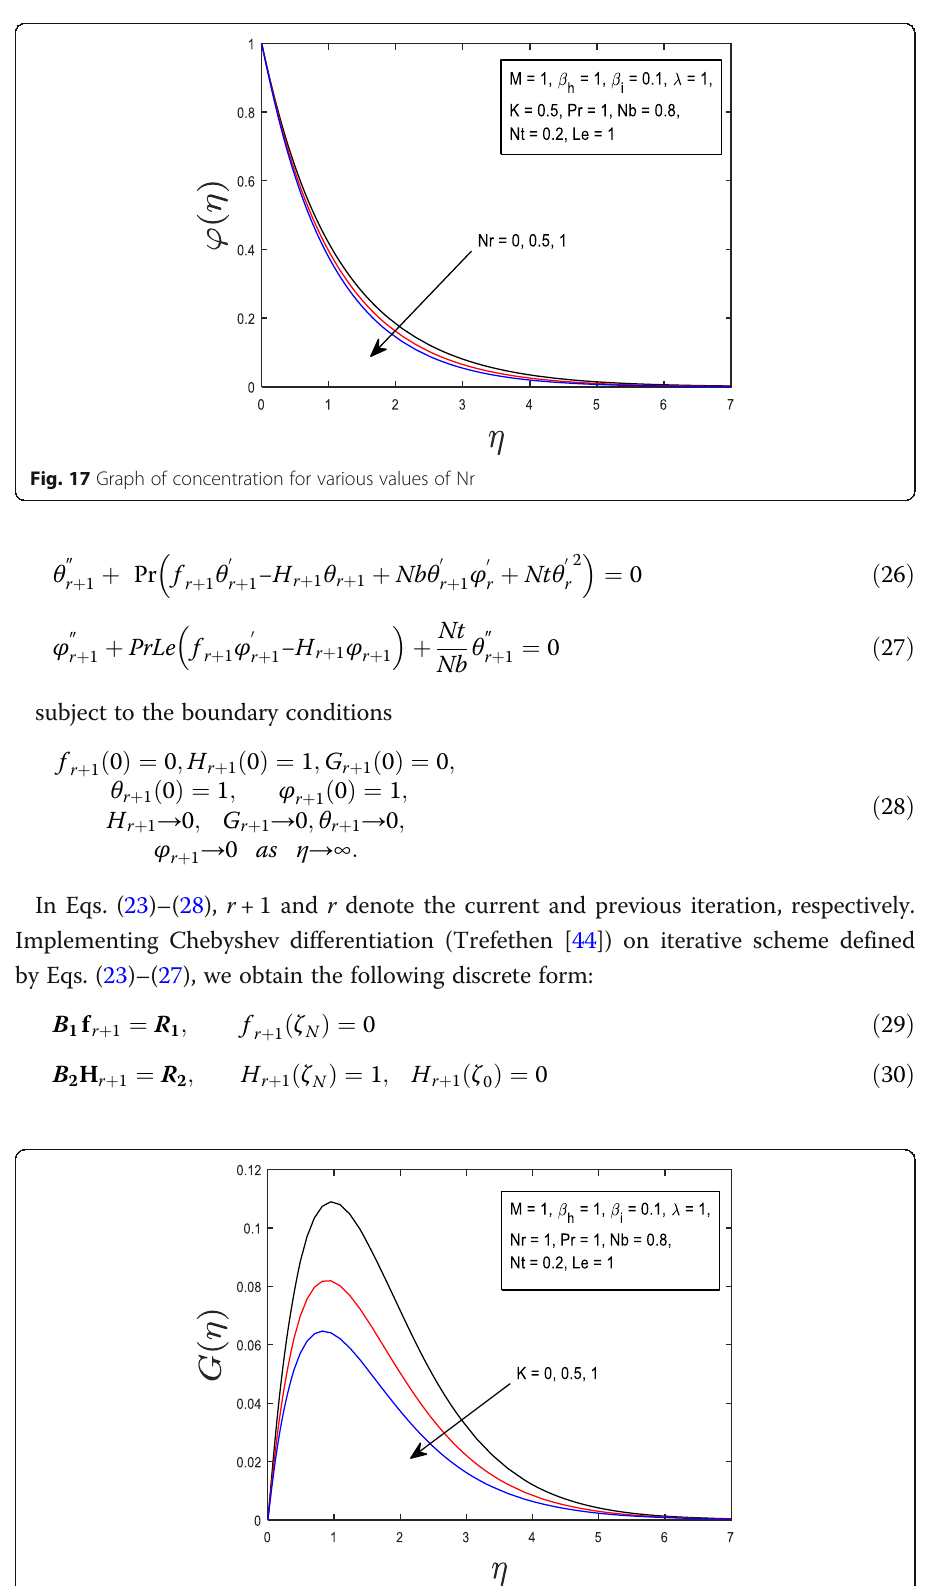
Fig. 18 Graph of cross flow profiles for various values of